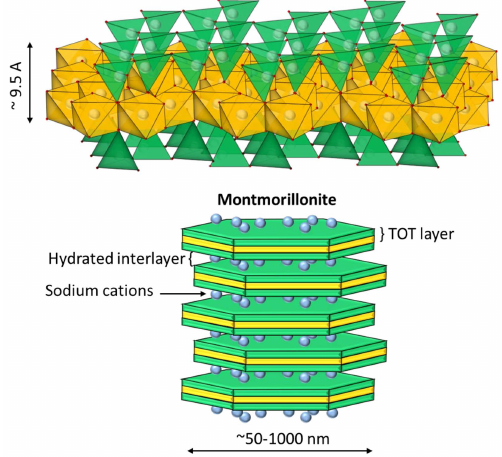
Figure 2. Structure of Na-montmorillonite. The green sheet indicates a tetrahedral silica layer (T), the yellow sheet indicates an octahedral alumina layer (O), and the blue spheres represent sodium